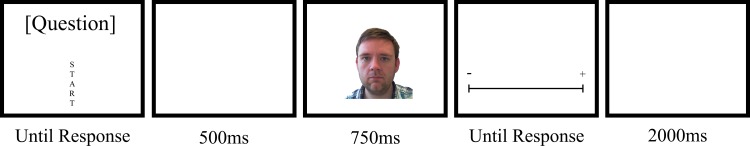
A standard trial during the Rating Stages (1 and 3).All faces were presented centrally with a neutral expression for the timing durations shown. ‘Question’ refers to: “How trustworthy is this person?”